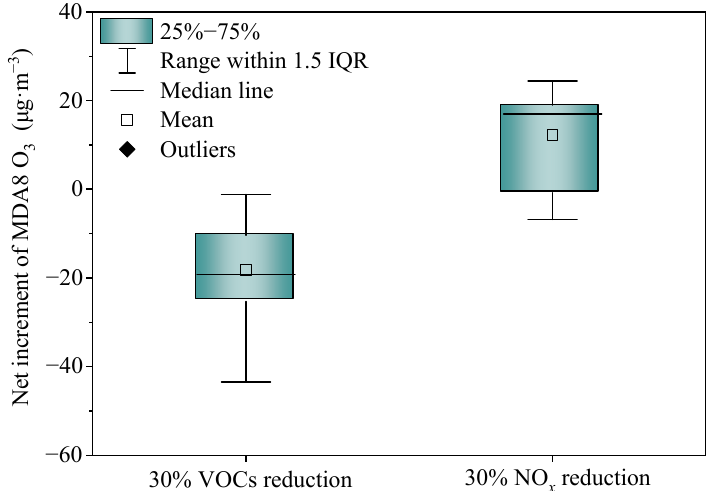
Figure 8. Net increment of MDA8 O 3 concentration for a 30% reduction in VOCs and NO x in downtown Handan during June 2018.